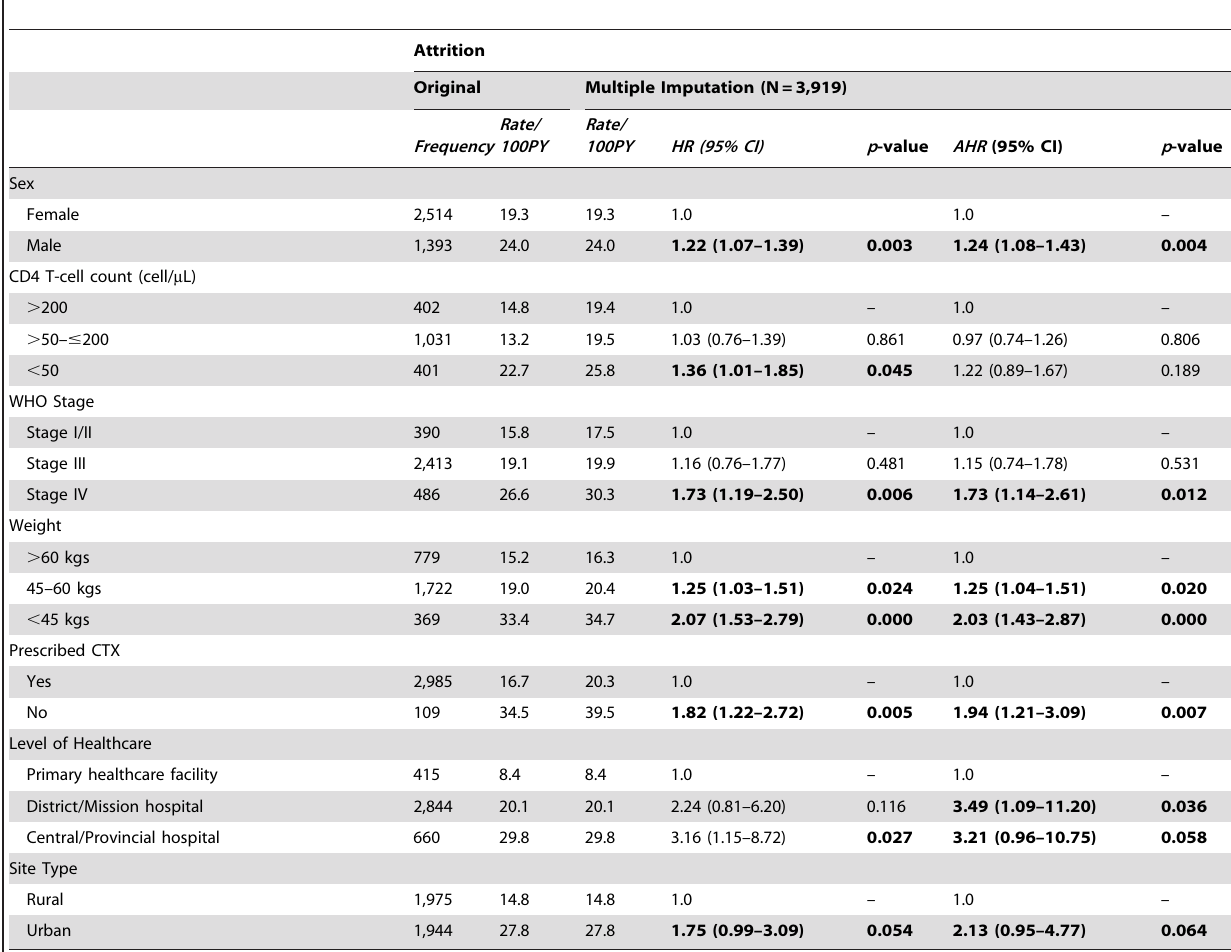
Table 5. Factors associated with attrition including patient characteristics at ART initiation, clinical practices and healthcare facility type and